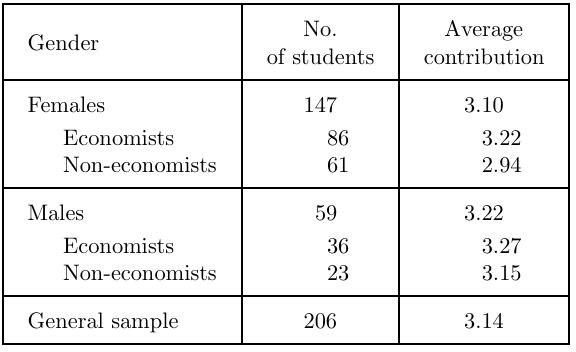
Contributions to the common fund according to the respondents’ gender